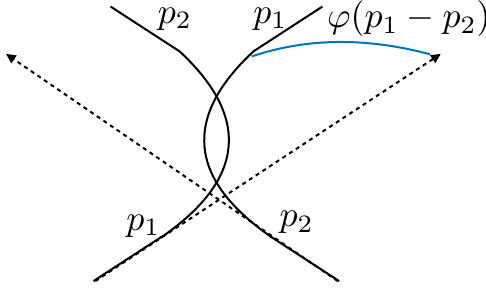
Figure 7: The two-body scattering